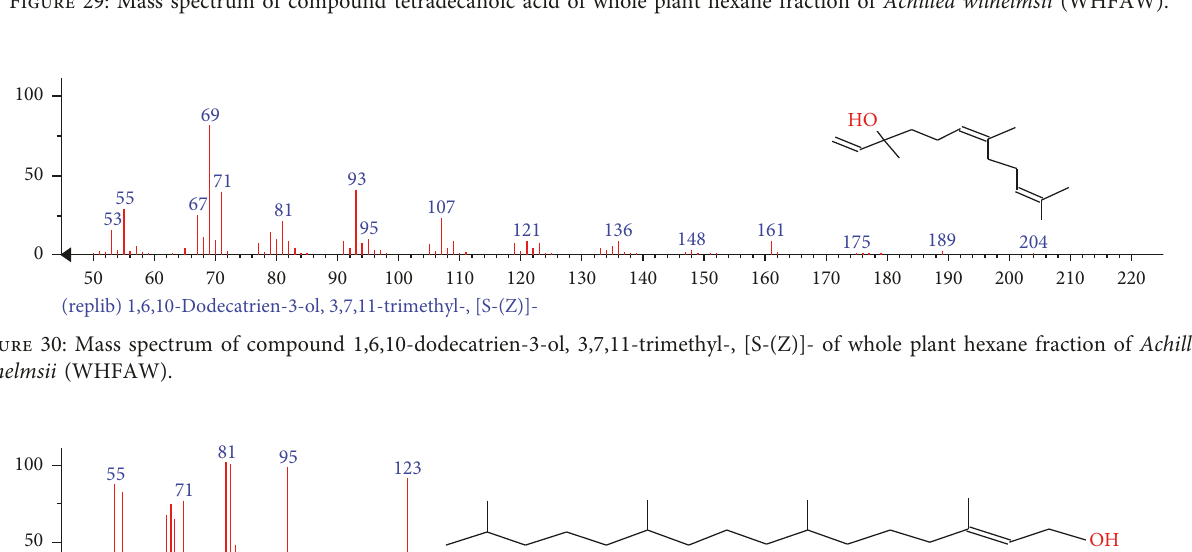
Figure 29: Mass spectrum of compound tetradecanoic acid of whole plant hexane fraction of Achillea wilhelmsii